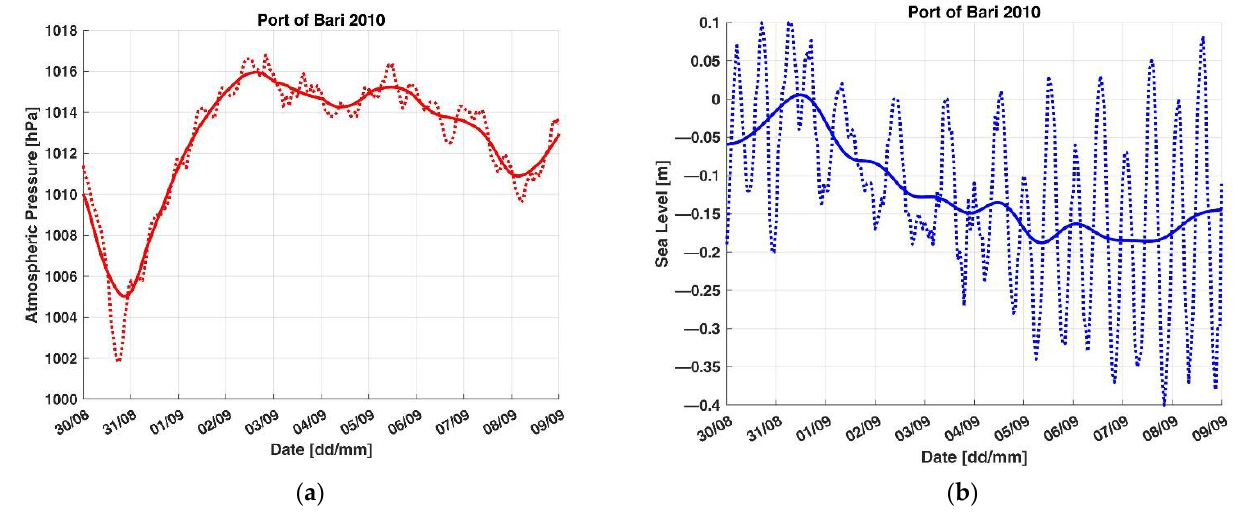
Figure A11. Low-frequency components of meteo-mareographic parameters acquired by ISPRA’s monitoring station in the port of Bari from 30 August to 9 September 2010: ( a ) atmospheric pressure; ( b ) sea level.